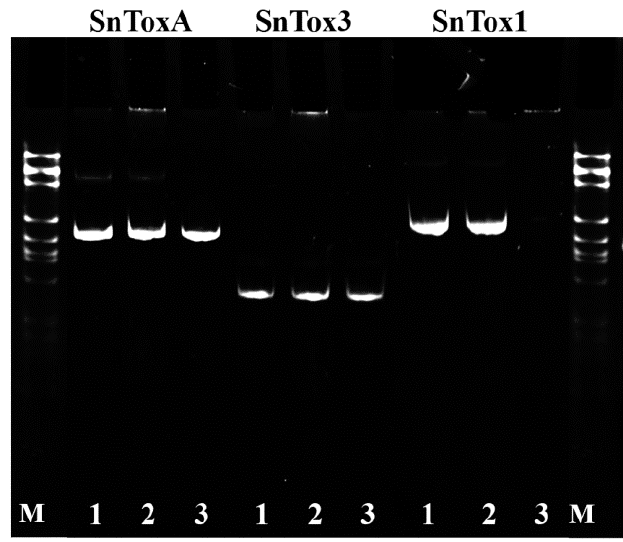
Figure 2. Identification of the SnToxA , SnTox3 and SnTox1 genes by PCR in tree isolates of S. nodorum : 1. Sn4VD; 2. Sn9MN; 3. SnB; M—DNA molecular weight ladder 100–1000 bp. Investigation of the transcriptional activity of NE genes in three S. nodorum isolates